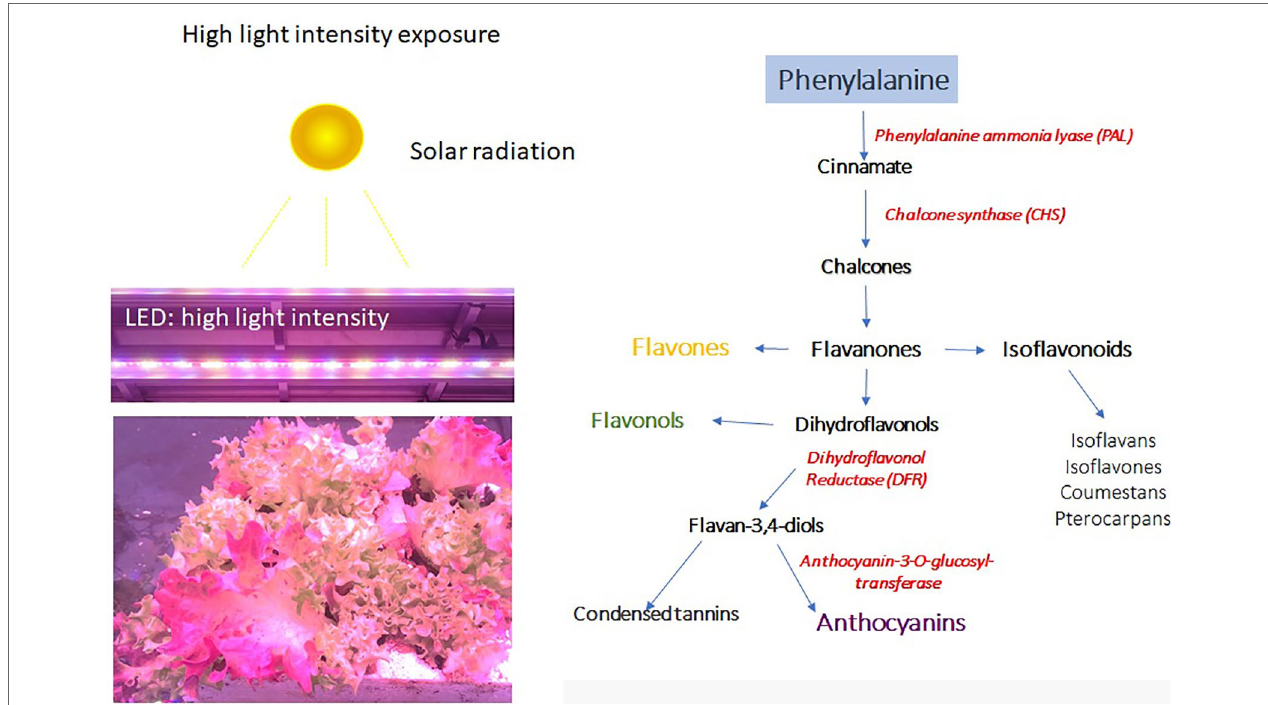
FIGURE 3 | High solar radiation or artificial lighting can induce the biosynthesis of anthocyanins and other phenylpropanoid